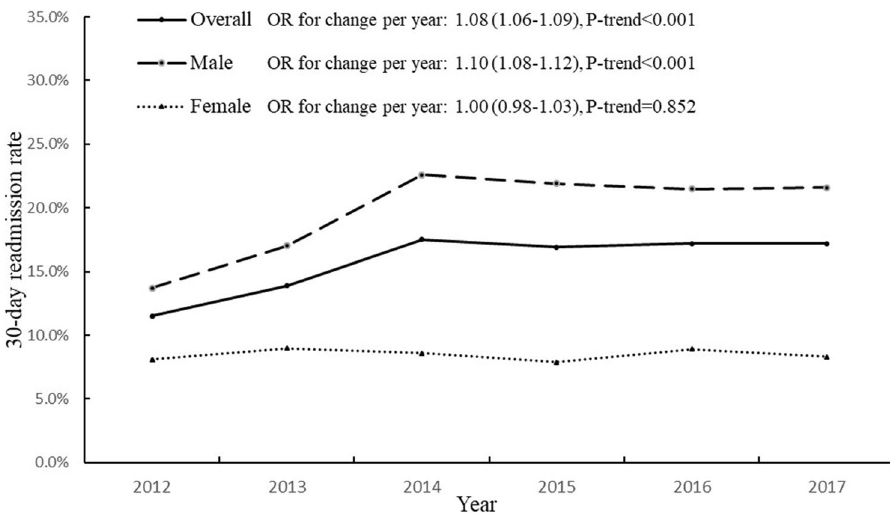
Figure 2. Gender-specific trends in 30-day COPD readmission rates during 2012–2017. ORs (95% CIs) for change in readmission rates per year were calculated using logistic regression models. Covariates included age, sex (for total population), hospital level, Charlson index, length of hospital stay, and use of mechanical ventilation at index